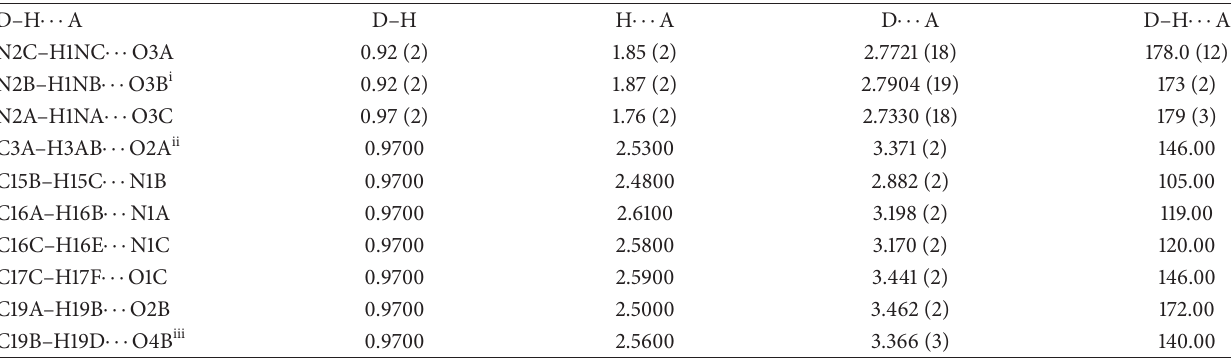
Table 2: Hydrogen-bond geometry (˚A, ∘